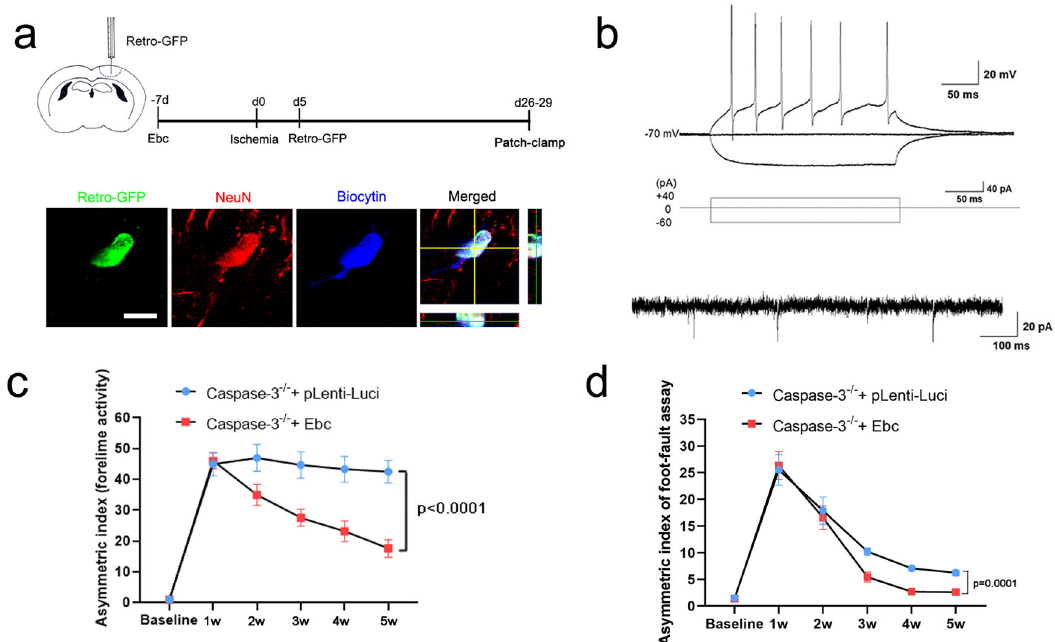
Fig. 7 Promotion of functional recovery of caspase-3-de fi cient mice by stabilized β -catenin. a Experimental design and triple-staining of Retro-GFP/NeuN/Biocytin in patch-clamped cells. Bar = 10 μ m. b Typical action potentials of recorded cells and typical EPSCs of the spike- fi ring cells. Nine (out of the 23) patched Retro-GFP-positive cells fi re action potentials. Notice the spontaneous synaptic activities. c Glass sliding test. Stabilized β -catenin in Caspase-3 − / − mice signi fi cantly reduces sliding incidence of the contralateral forelimb in the glass cylinder from 3w post-injury. N = 6 mice per group. P < 0.0001 (2w, 3w, 4w and 5w). Two-way RM ANOVA. d Foot-fault test. Stabilized β -catenin reduces foot-fault incidence of the contralateral forelimb on a horizontally placed ladder from 3w post-injury. N = 6 mice per group. P = 0.0001 (3w, 4w, and 5w). Two-way RM ANOVA. P values indicate comparison of experimental group with control group at same time point. Mean ± standard error